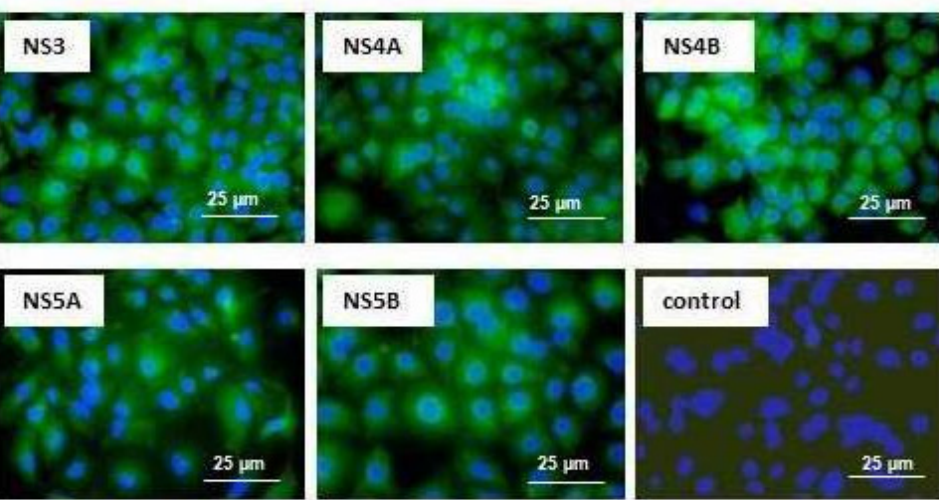
Figure 1. Immunocytochemical staining of hepatitis C virus (HCV) nonstructural proteins in Huh7.5 cells transfected with the pcNS3-NS5B plasmid. Expression of HCV proteins in the transfected Huh7.5 cells was determined by the method of indirect immunofluorescence using monoclonal antibodies (mAbs) against HCV proteins and anti-mouse secondary antibodies conjugated to fluoresceine isothiocianate (FITC; green). The detected HCV proteins are indicated and the mAbs used are listed in Section 4.5. Green staining of HCV proteins is observed in the cytoplasm of cells, merged with nuclear staining with DAPI (blue); no HCV-specific staining was seen in transfected cells stained with mAb to HBsAg (control). Scale bar = 25 µM.